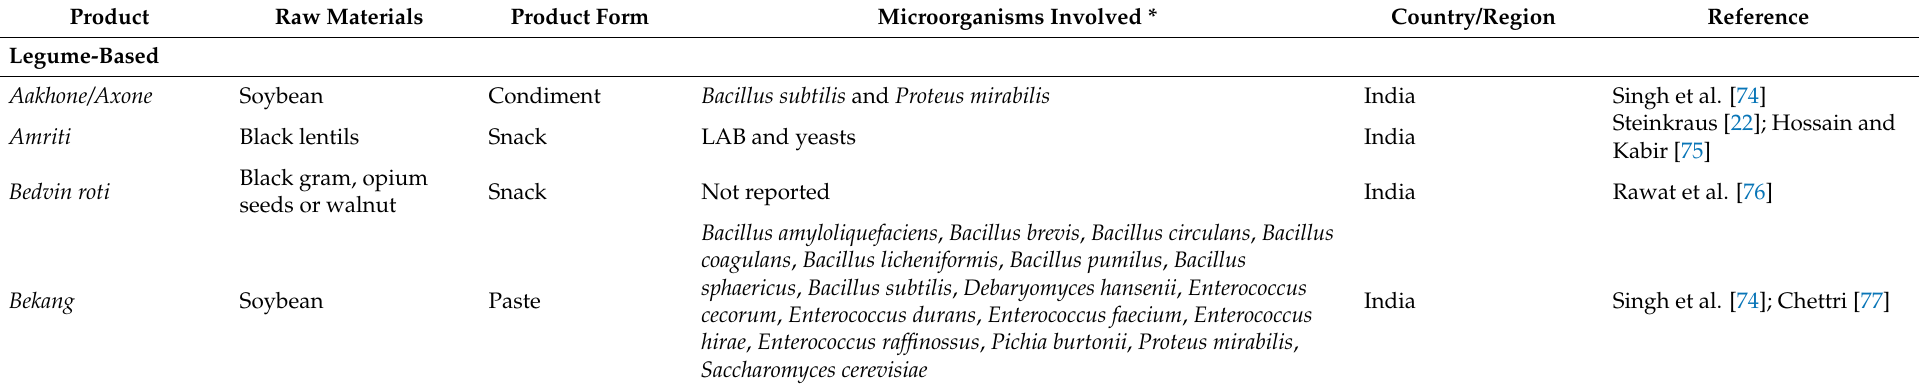
Table 2. Some legume fermented products and associated microorganisms responsible for